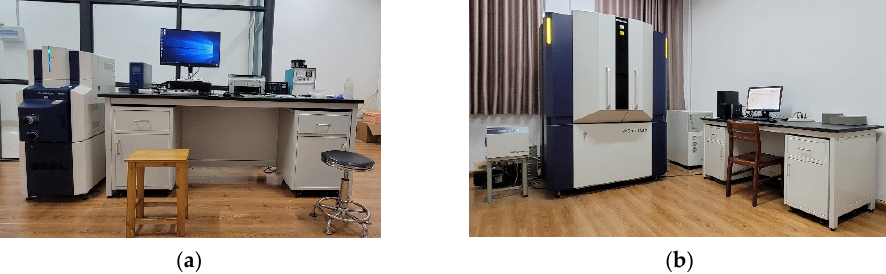
Figure 2. Split Hopkinson pressure bar test equipment: ( a ) picture of the split Hopkinson pressure bar and ( b ) schematic of the split Hopkinson pressure bar.